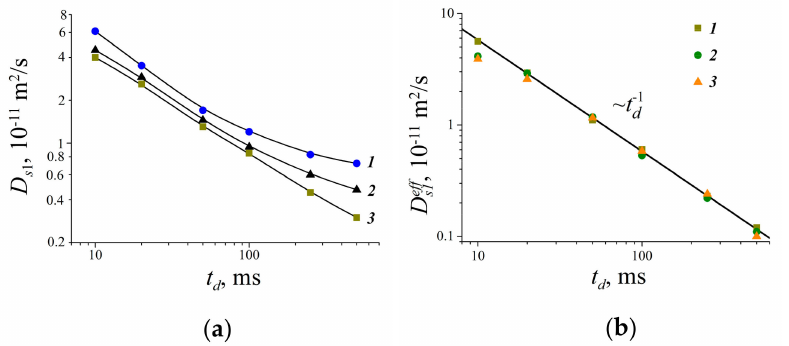
Figure 62. The experimental dependence of self-diffusion coefficients D s ( t d ) ( a ) T = 35 (1), 20 (2), and 5 (3) ◦ C and effective self-diffusion coefficients D seff ( t d ) calculated from Equation (A5) ( b ) T = 35 (1), 25 (2), and 10 (3) ◦ C on the diffusion time t d for intracellular water molecules in the RBCs. Reprinted with permission from [171]. Copyright 2016 Springer